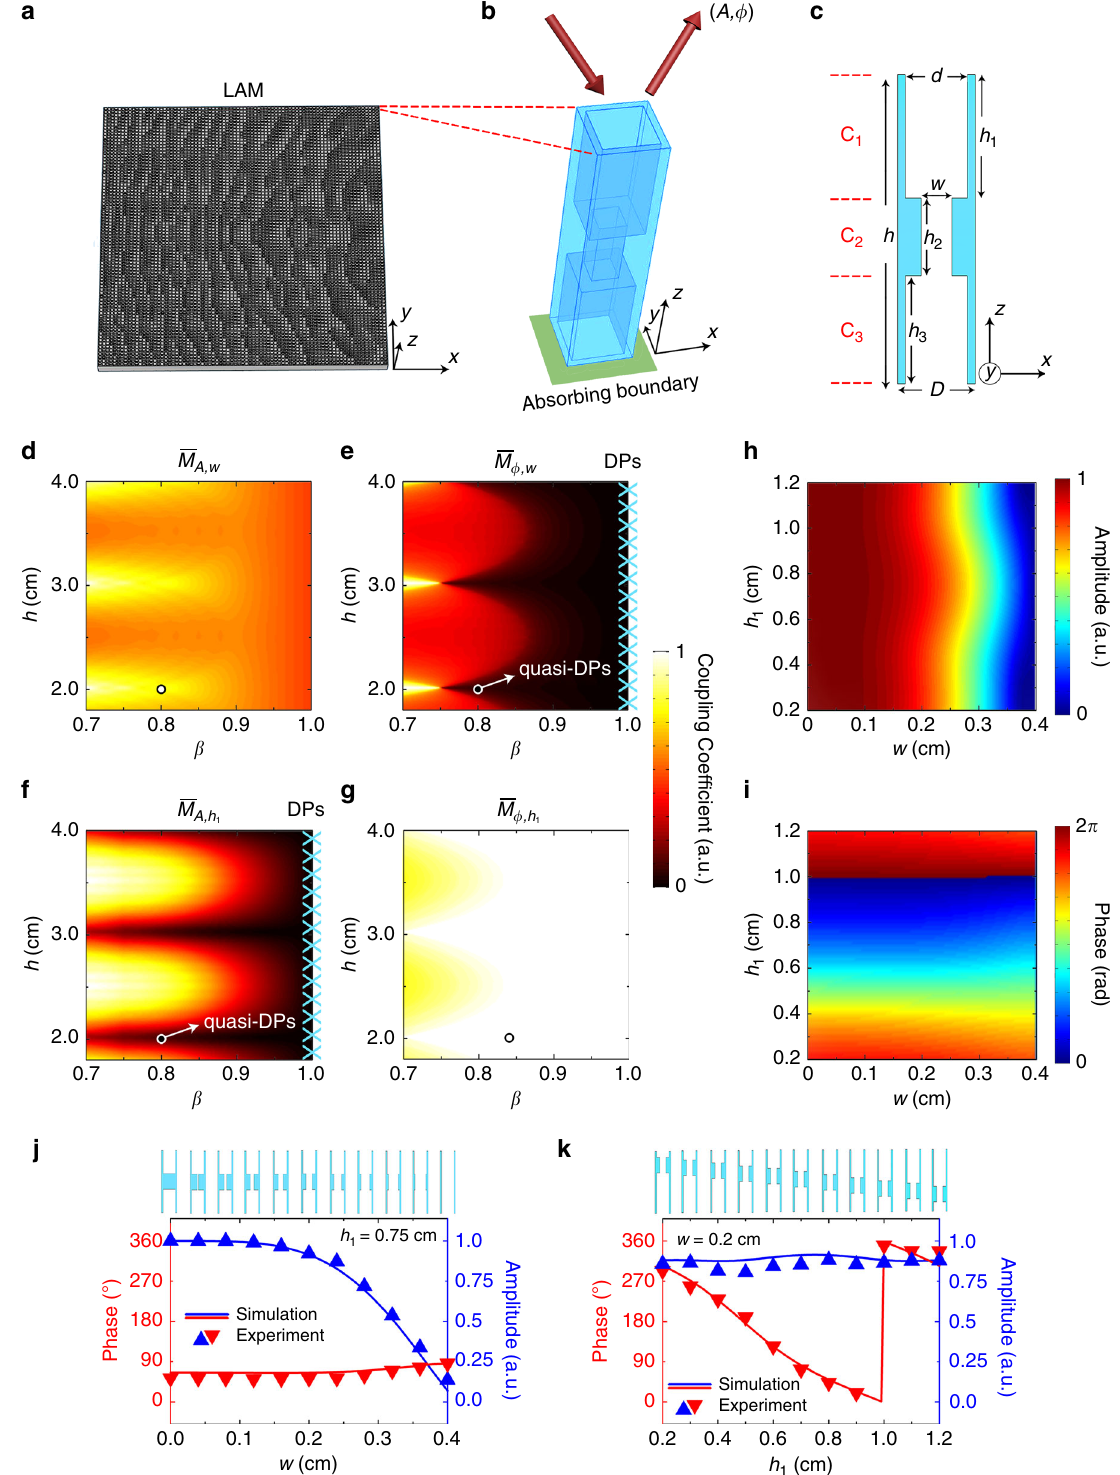
Fig. 1 Decoupled modulation of re fl ection amplitude and phase. a – c Schematic diagram of holey lossy metamaterials with an absorbing boundary at the back side in a , three-dimensional (3D) illustration in b and cross-section view of a unit cell in c are appended. d – g The coupling coef fi cients M A ð ϕ Þ ; h and β with decoupled points (DPs) and quasi-DPs marked by the crosses and arrows, respectively. h , i The re fl ection amplitude and phase responses to the parameters h 1 and w for a unit cell operating at quasi-DPs. j , k The simulated and measured amplitude and phase vs. w and h 1 , respectively, which reveals that the re fl ection amplitude and phase are controlled by only one parameter, respectively. The simulations are carried out by the fi nite element solver in commercial software COMSOL Multiphysics TM